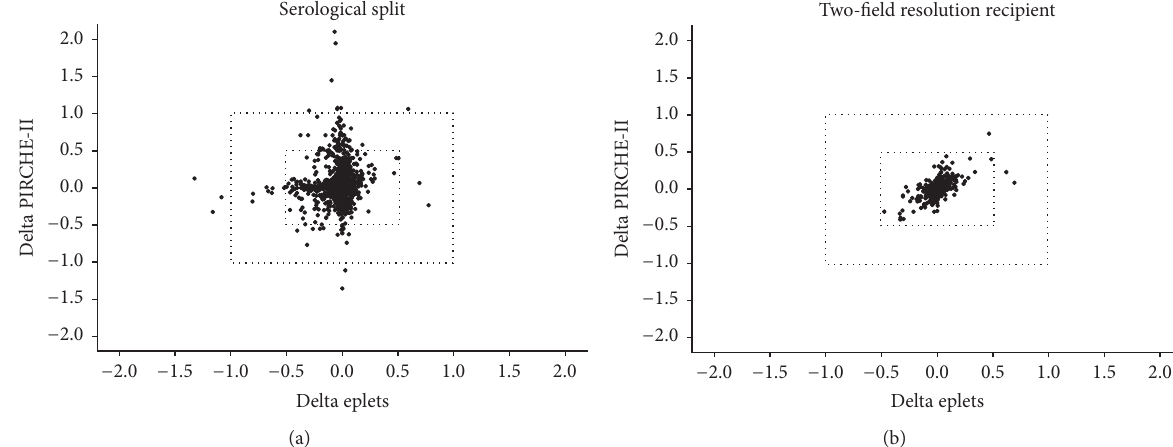
Figure 2: Comparison of the delta in ln(PIRCHE-II) and the delta in ln(eplet) . (a) When using serological split level HLA typing of both donor and recipient, the majority of the donor-recipient couples had a comparable ln(PIRCHE-II) and ln(eplet) delta. For 13 donor-recipient couples, the observed ln(PIRCHE-II) or ln(eplet) values deviated substantially ( > +1 or <− 1) from the reference ln(PIRCHE-II) or ln(eplet) values. (b) When using two-field resolution HLA genotype data of the recipient and serological split level HLA typing of donor the deviation between the observed ln(PIRCHE-II)/ln(eplet) values and the reference ln(PIRCHE-II)/ln(eplet) values substantially diminished. The dashed squares indicate the delta < 0.5 and delta < 1